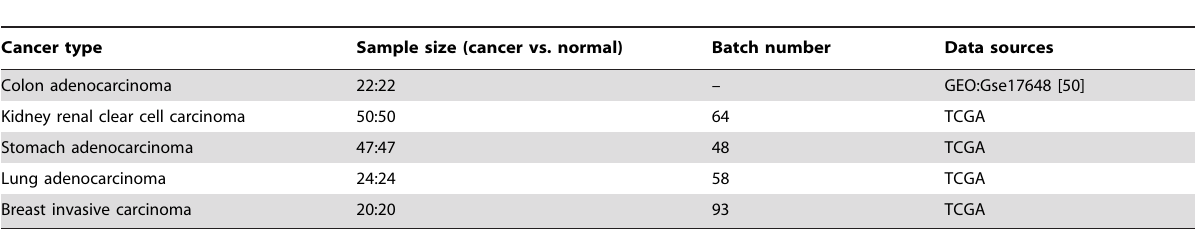
Table 1. The methylation data analyzed in this study.